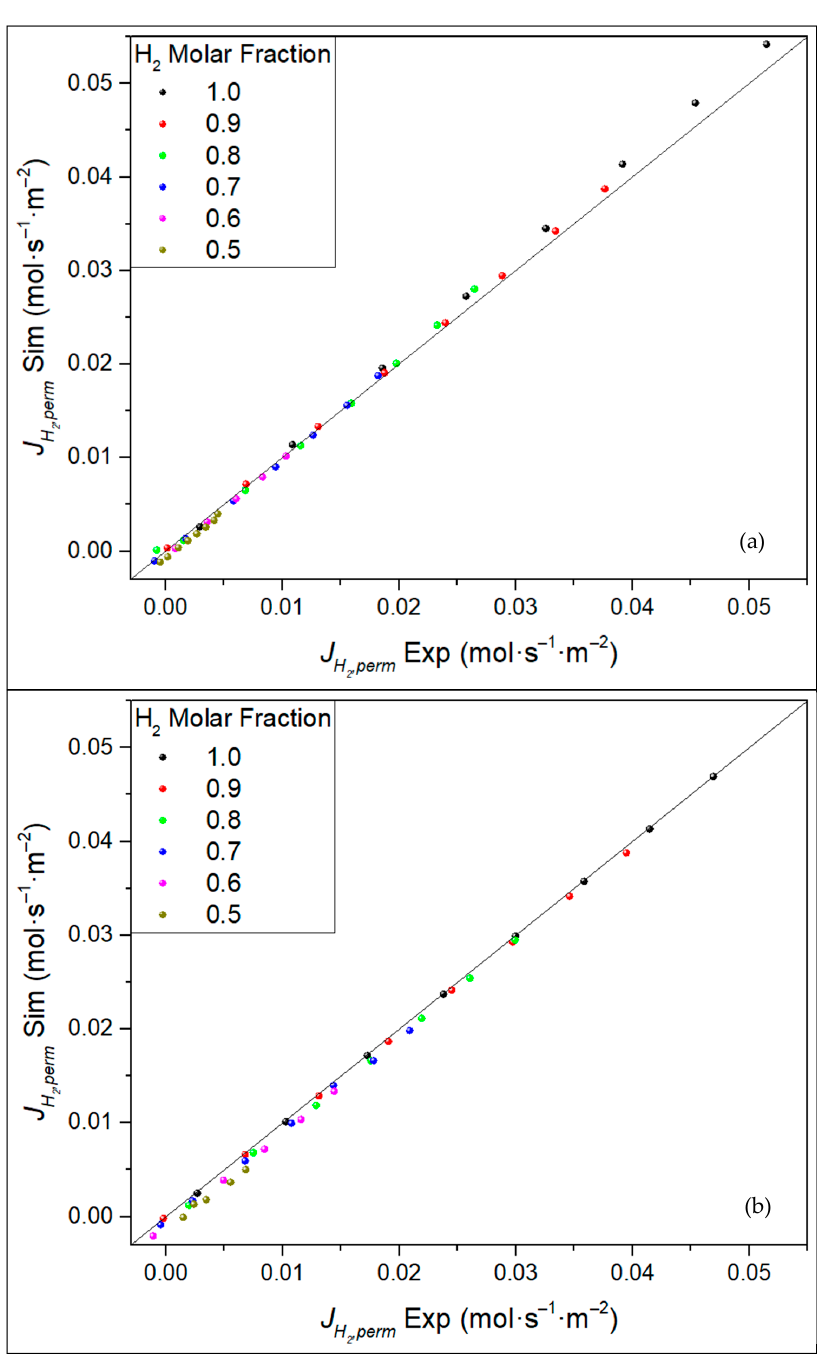
Figure 11. Parity plot for simulated permeation results against experimental ones for all the considered H 2 feed molar fractions for different operating modes: ( a ) in–out and ( b ) out–in.